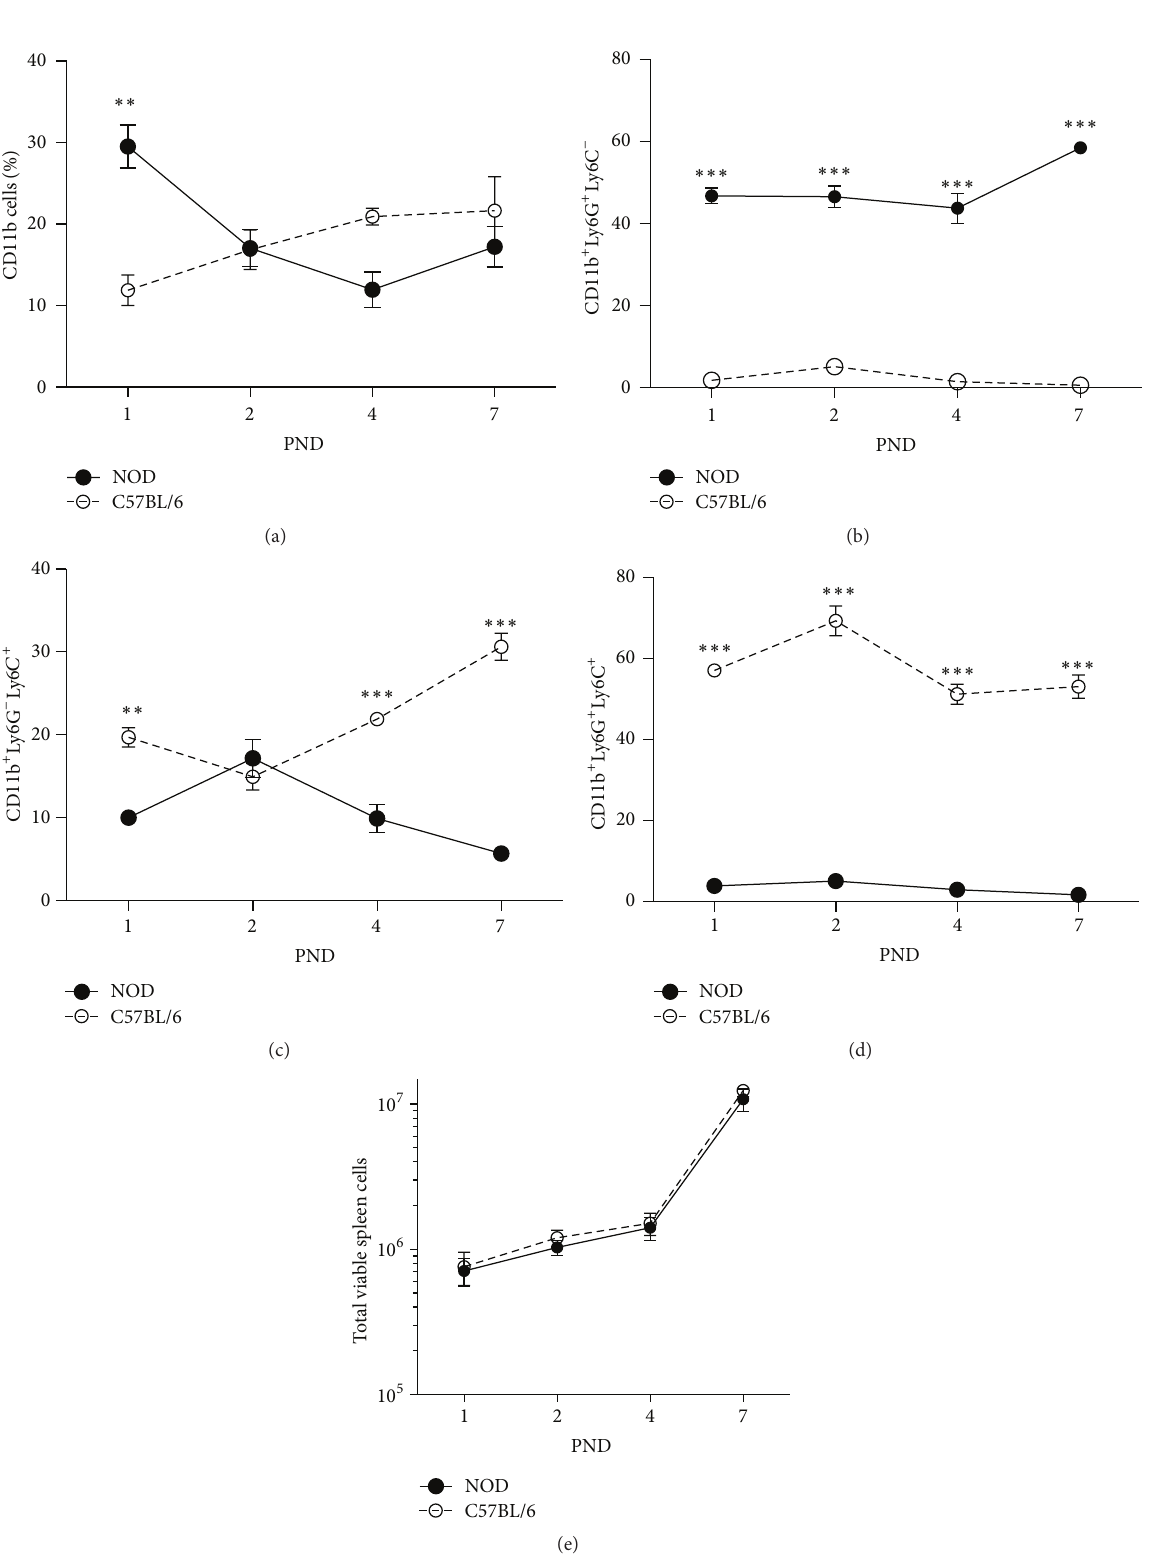
Figure 1: The proportion of CD11b + Gr-1 + splenocytes of newborn NOD mice is high compared to C57BL/6. Flow cytometric analysis of freshly isolated splenocytes from newborn NOD and C57BL/6 mice for the expression of CD11b, Ly6C, and Ly6G. (a) Time course development of the proportion of viable CD11b + spleen cells in NOD and C57BL/6 mice at PND 1, 2, 4, and 7. Graphs (b), (c), and (d) depict gated Ly6G-Ly6C + (d), Ly6G + Ly6C − (c), and Ly6G + Ly6C + (e) double positive cells. Backgating confirmed that all three populations were CD11b + . (e) Time course of the absolute number of viable cells in spleens of NOD and C5BL/6 mice. Data presented as mean ± SEM ( 𝑛 = 8 –12 spleens). ∗∗ 𝑝 < 0.05 . ∗∗∗ 𝑝 < 0.001